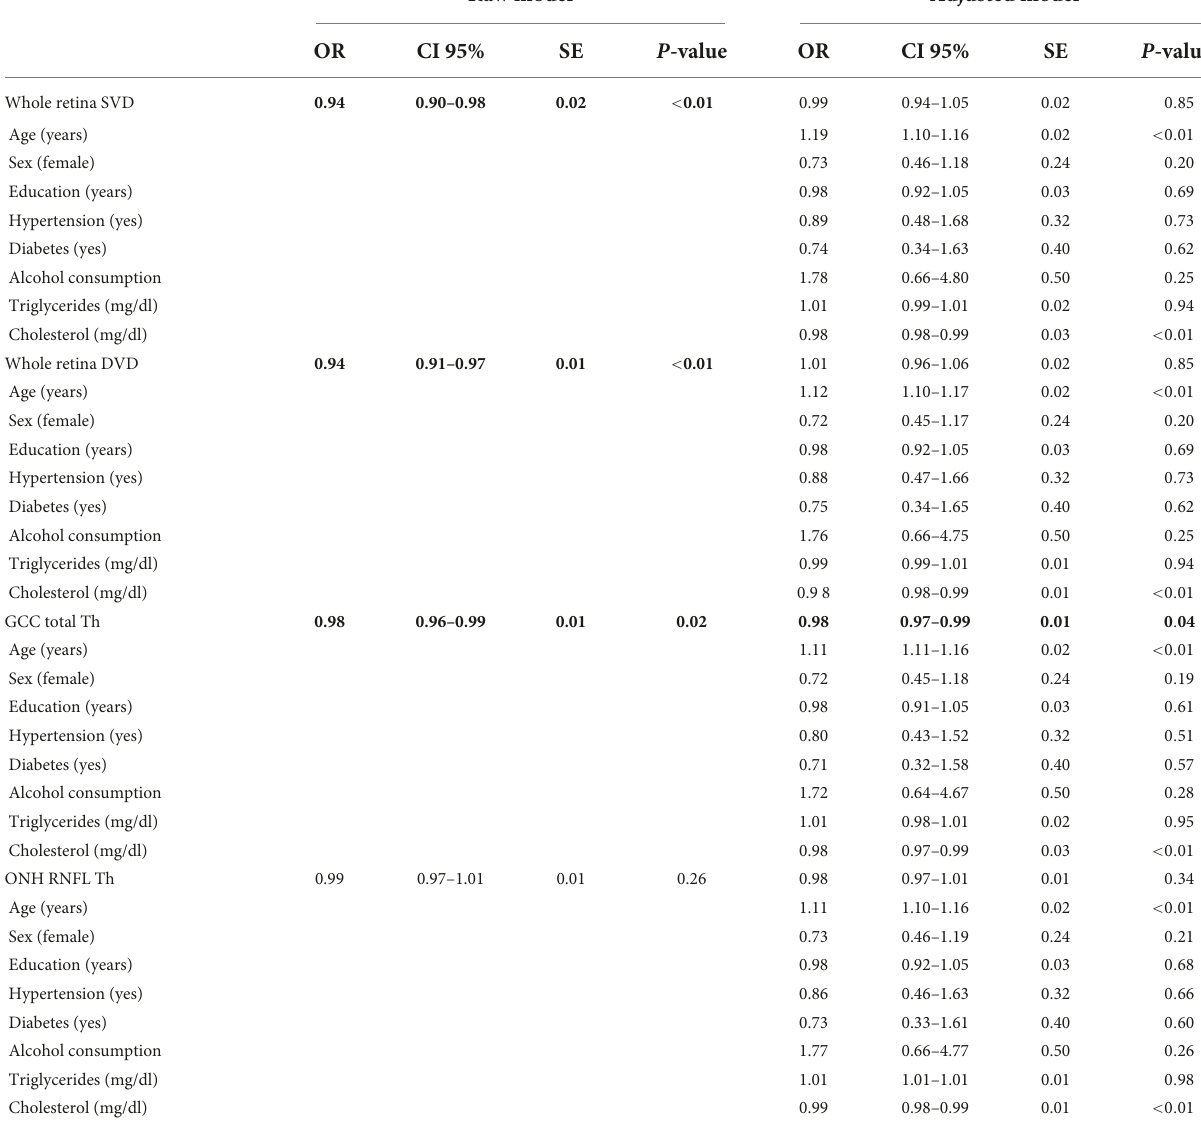
TABLE 4 Logistic regression models on the FIB-4 cut-off of > 2.67 (fibrosis/no fibrosis) and